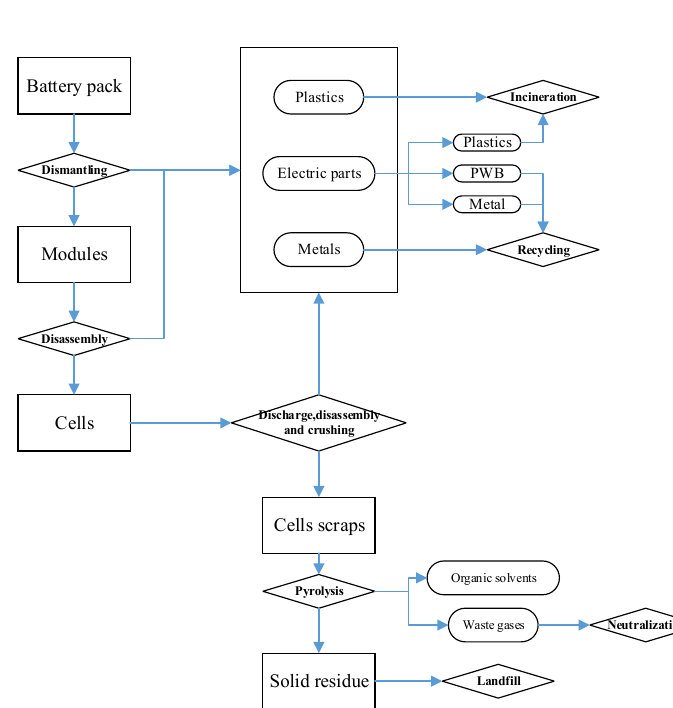
Figure 2. The total disposal process of LiFePO 4 vehicle battery.